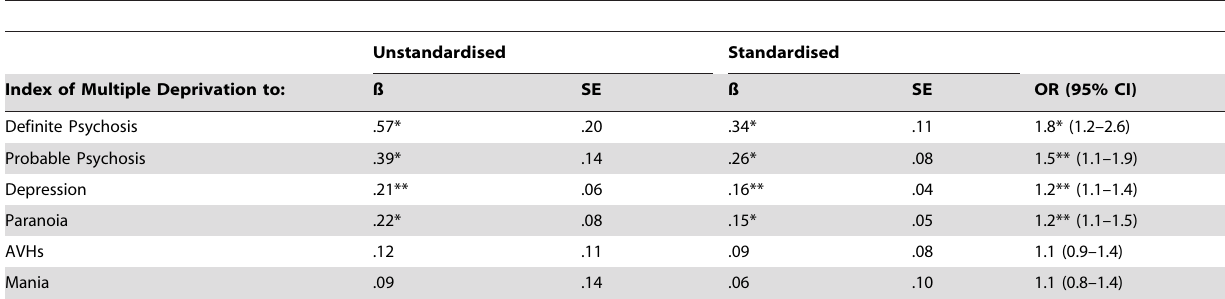
Table 2. Summary of logistic regression analysis for variables predicting mental health outcomes, controlling for background variables (age, sex, ethnicity, education and drug use).